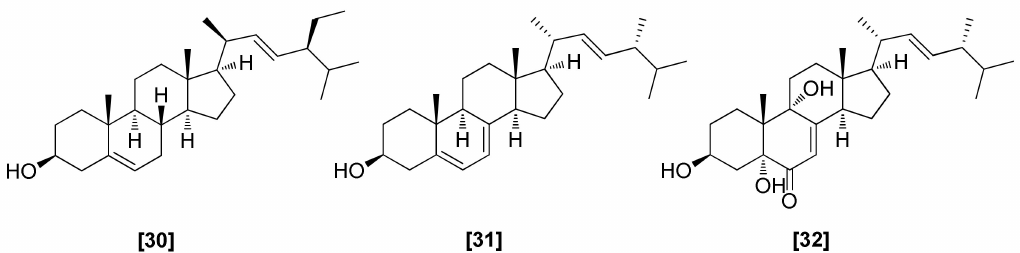
Figure 8. Structures of antifungal steroids from Trichoderma spp.: [30] stigmasterol, [31] ergosterol, [32] 3,5,9-trihydroxyergosta-7,22-dien-6-one.